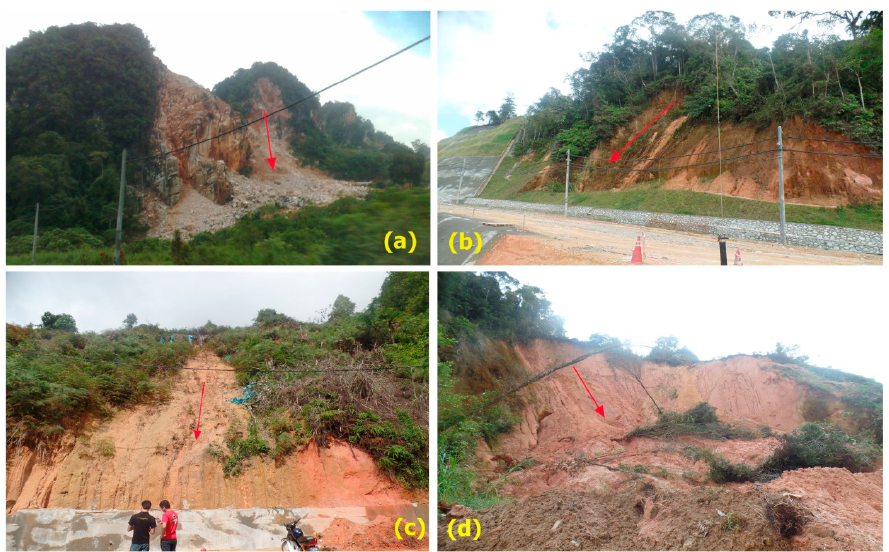
Figure 3. Field photographs of recent landslides and types of landslides: ( a ) a shallow translational rockslide, ( b ) a shallow translational slide at the road side, ( c ) a rotational slide and ( d ) deep-seated rotational slide. The arrow depicts the movement direction.